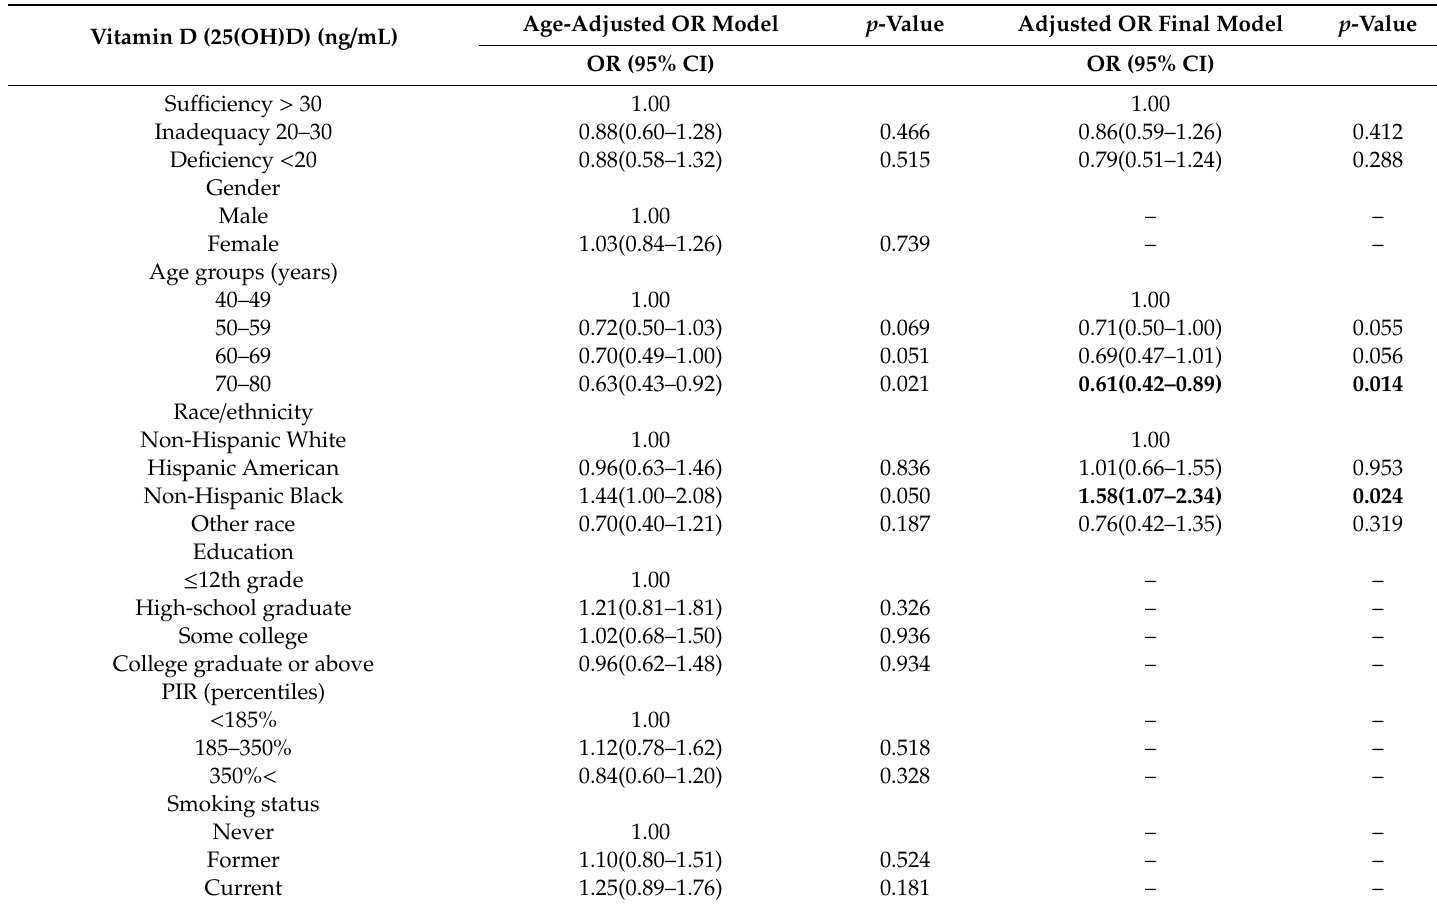
Table 3. Adjusted associations between Vitamin D (25(OH)D) and taste impairment among American adults aged 40–80 years ( n = 2636), the NHANES